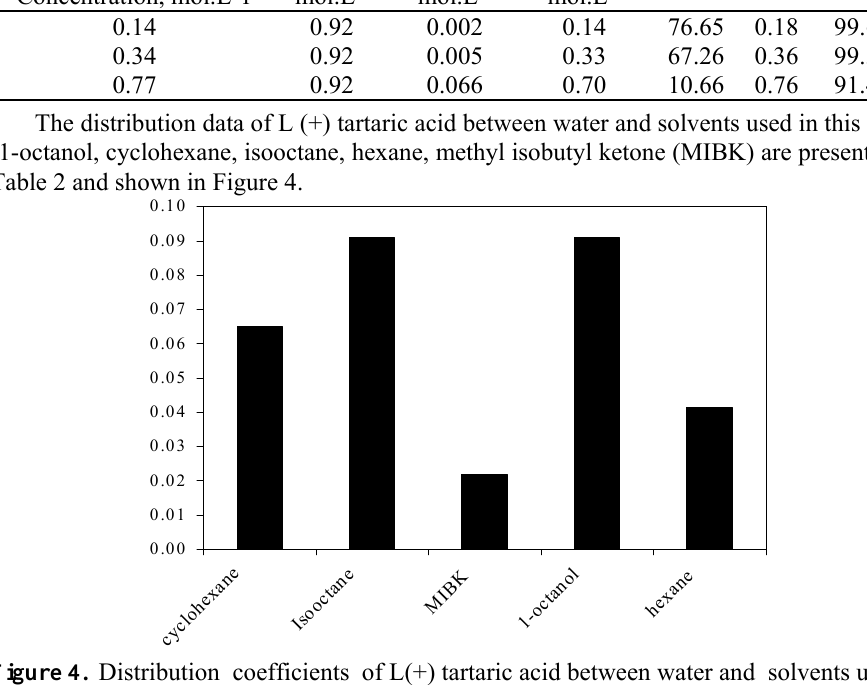
Table 3. Effect of initial acid concentration on the extraction of L(+) tartaric acid Initial Acid